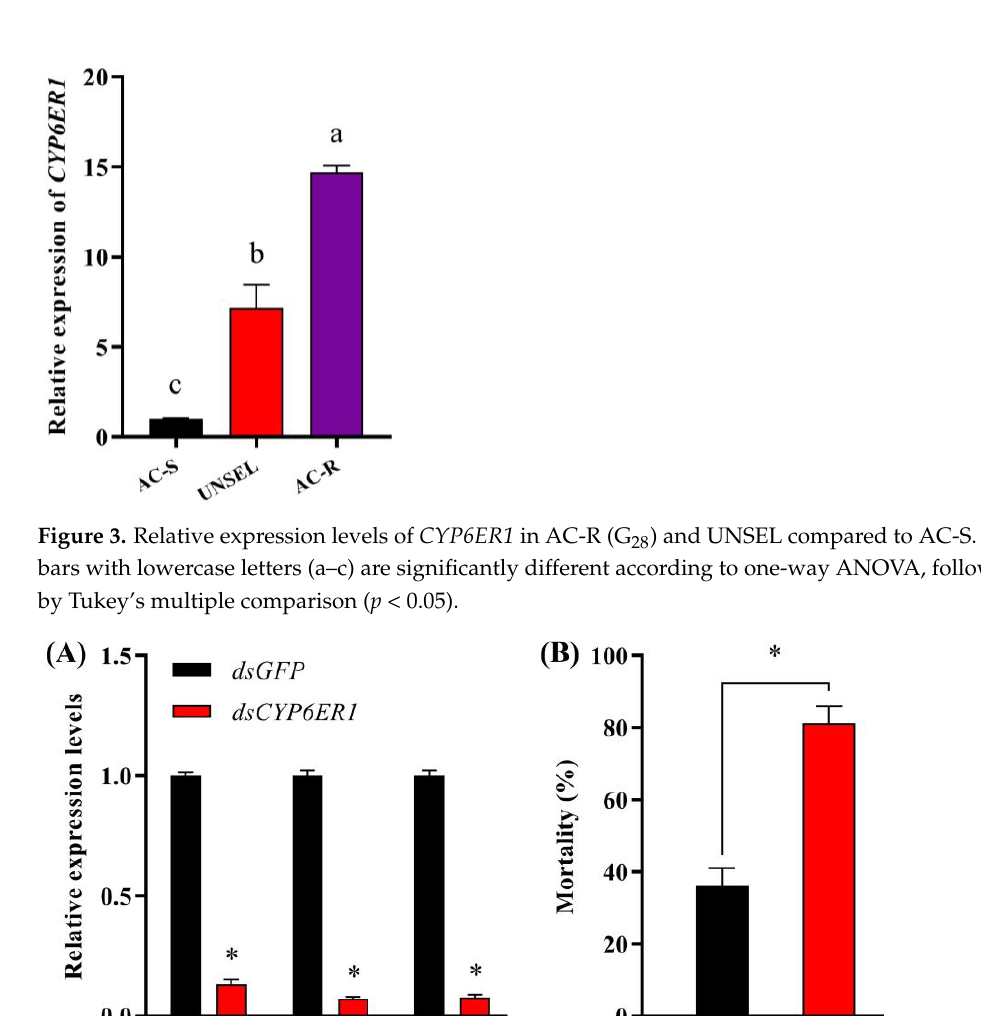
Figure 4. Functional analysis of CYP6ER1 by RNAi. ( A ) Relative expression of CYP6ER1 in fifth- instar nymphs injected with dsGFP or dsCYP6ER1 . ( B ) Mortality at 96 h of dsRNA-injected fifth- instar nymphs after treatment with acetamiprid (800 mg/L). * The asterisk indicates significant dif- ference between the dsCYP6ER1 - and dsGFP - injected groups (Student’s t -test; p < 0.05).